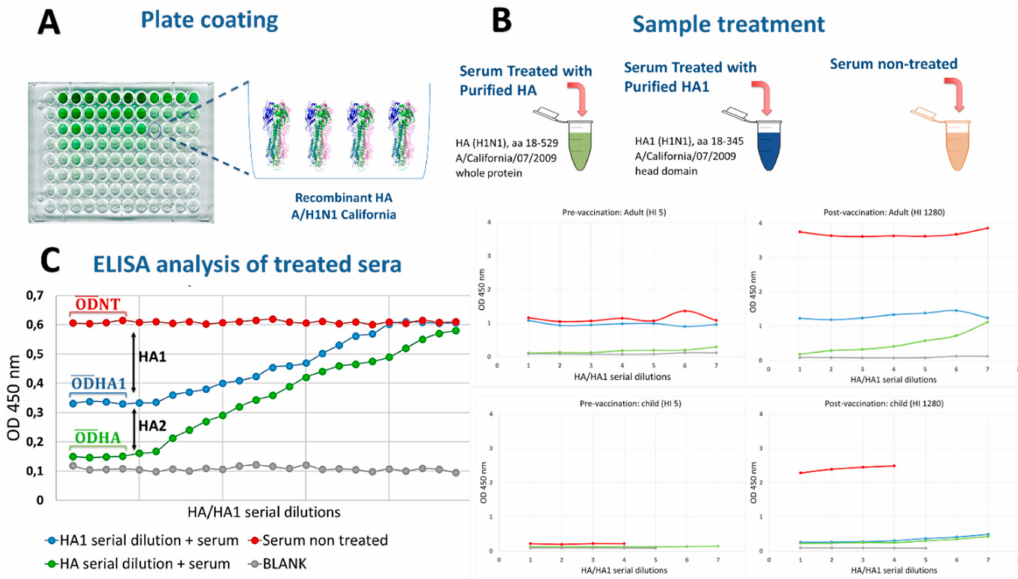
Figure 1. Schematic overview of the competitive ELISA method. ( A ) ELISA plates were coated with a purified hemagglutinin (HA) recombinant protein from A / California / 7 / 2009 (H1N1) influenza strain. ( B ) A 1:250 pre-diluted serum sample is treated and incubated with di ff erent HA and HA1 concentrations. ( C ) The resulting OD di ff erence between the highest head domain (HA1)-treated and the HA-treated sample can be attributed to the stalk domain (HA2) response. Two examples of treatment are reported, with appreciable pre-vaccination di ff erences in the HA2 response between adults and children. ODHA1 is the average optical density (OD) of the samples that were incubated with the head protein (HA1); ODHA is the average OD of the samples that were incubated with the HA protein; and ODNT is the average OD of the samples that were incubated with the bu ff er (non-treated